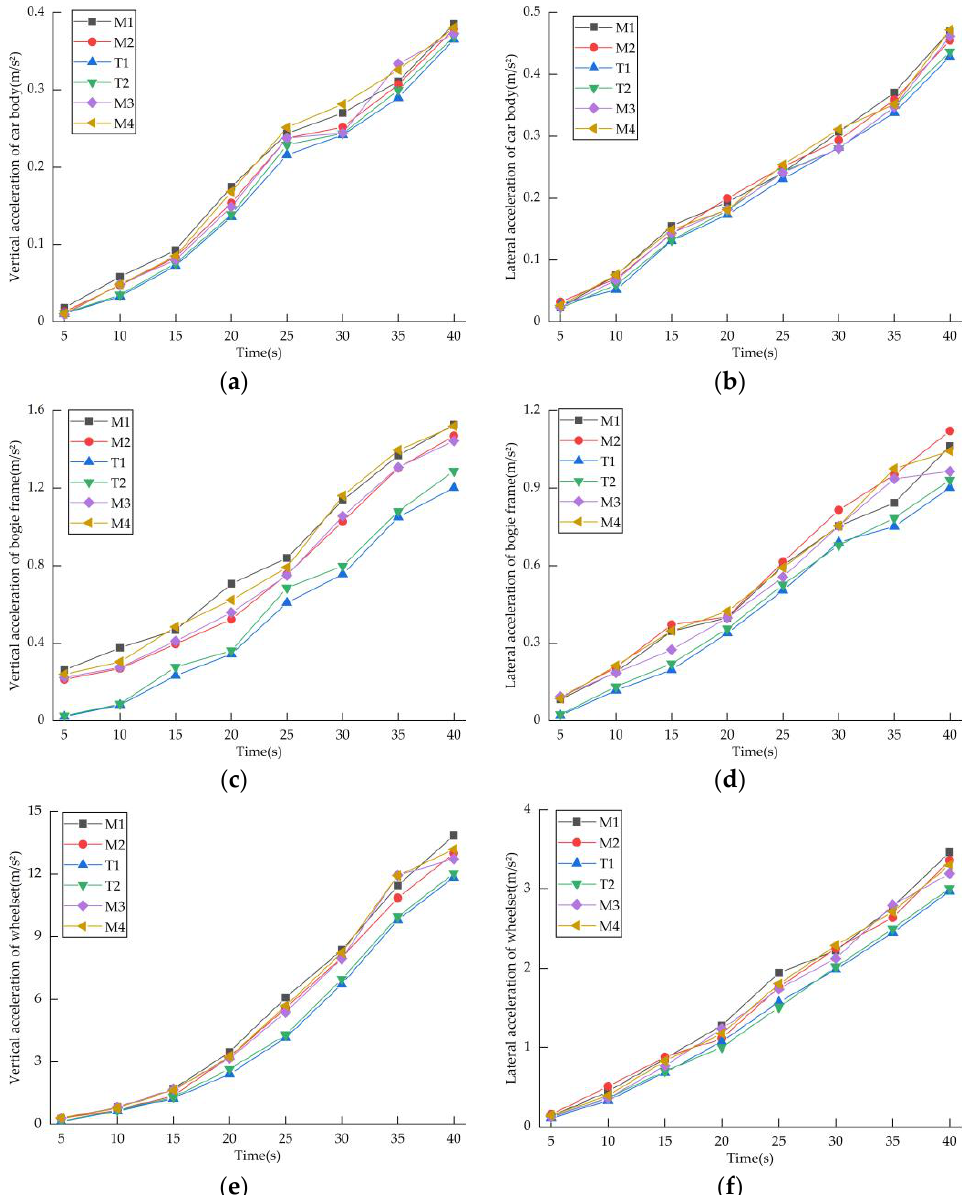
Figure 10. Vibration acceleration of each component of the marshaling urban rail train: ( a ) vertical acceleration of car body; ( b ) lateral acceleration of car body; ( c ) vertical acceleration of bogie frame; ( d ) lateral acceleration of bogie frame; ( e ) vertical acceleration of wheelset; and ( f ) lateral acceleration of wheelset.